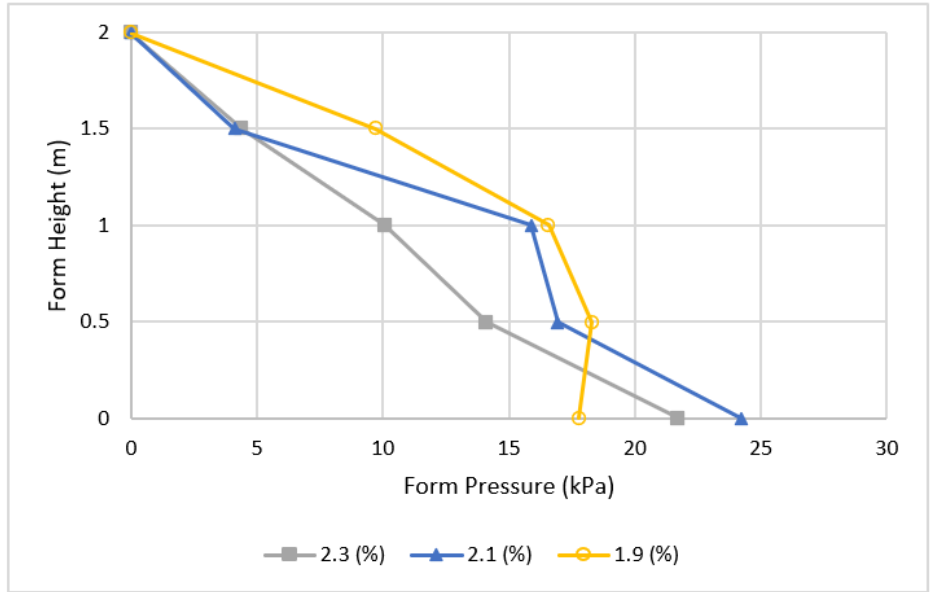
Figure 8. The effect of different air content on pressure.